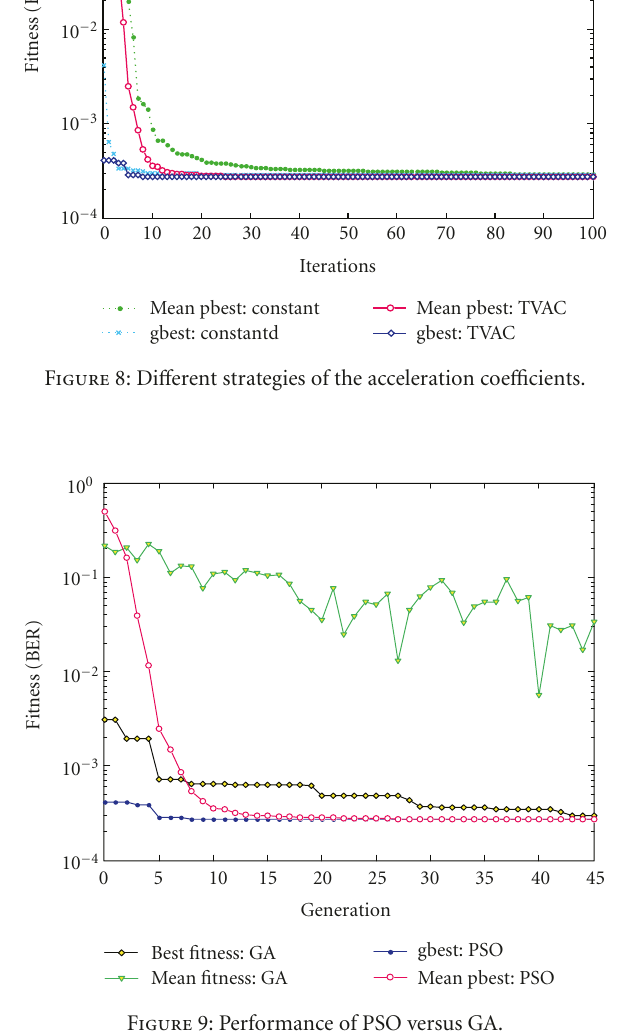
Figure 9: Performance of PSO versus